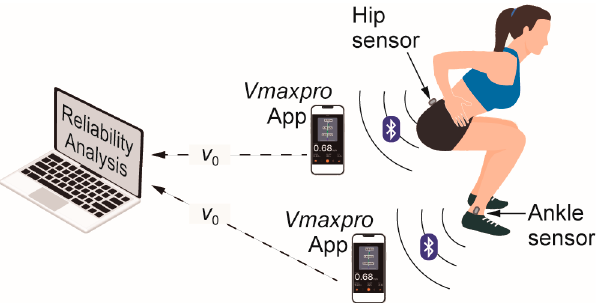
Figure 1. Experimental setup showing the locations of the two Vmaxpro devices: hip (close to the center of mass, as indicated by the manufacturer), and ankle (tibial malleolus). Data are sent to smartphones via Bluetooth and the take-off velocity v 0 is used to conduct the reliability analysis.